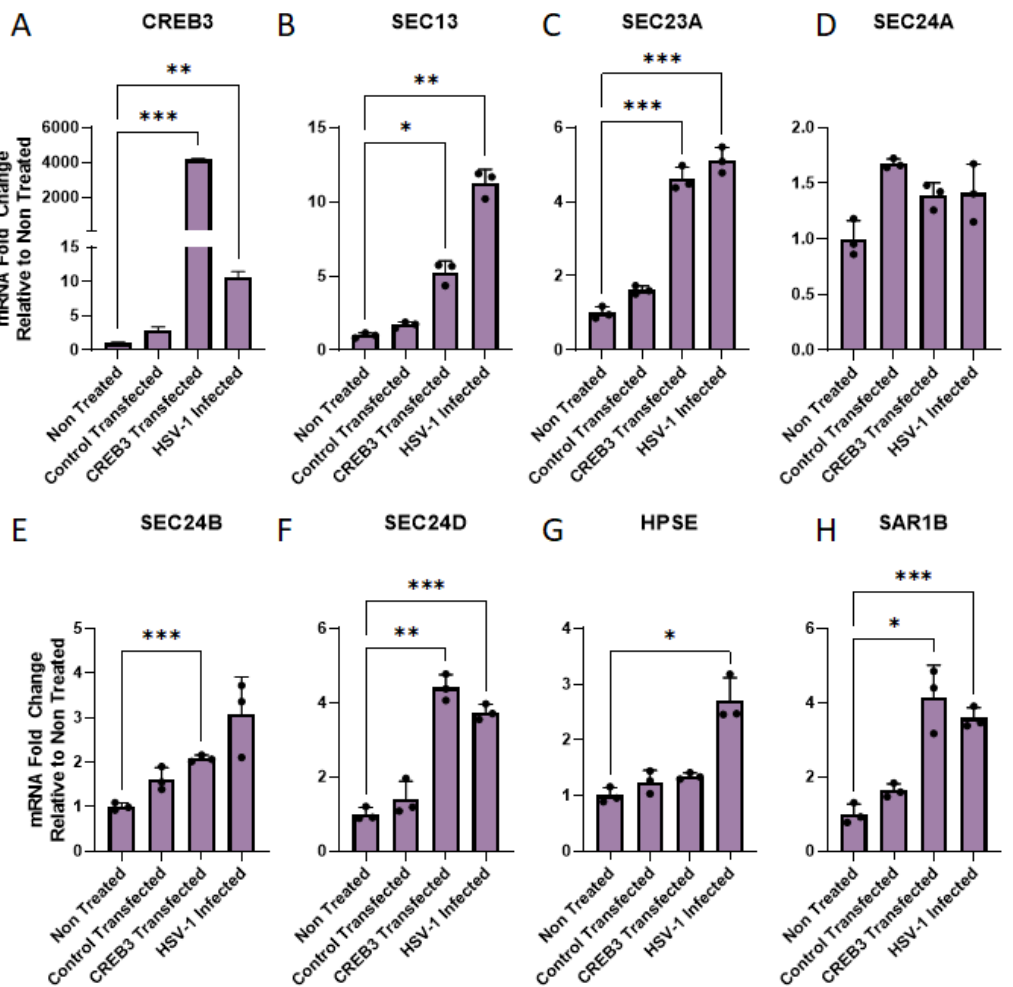
Figure 4. Upregulation of CREB3 increases COPII vesicle transcripts: ( A ) Human corneal epithelial cells were transfected with a control plasmid, CREB3 plasmid, or full-length HPSE plasmid for 48 h. Total cellular RNA was extracted from the samples using the TriZol technique, reverse transcribed to form cDNA, and analyzed via RT-qPCR. ( A ) qPCR confirmation of CREB3 upregulation in transfected cells. ( B – H ) COPII vesicle machinery and HPSE mRNA transcripts shown as a fold-change relative to non-transfected samples. Two-way ANOVA was used to determine statistical differences between rows (treatment groups) within a given a column (mRNA transcript expression level). * p -value < 0.05, ** p < 0.01, *** p < 0.001.